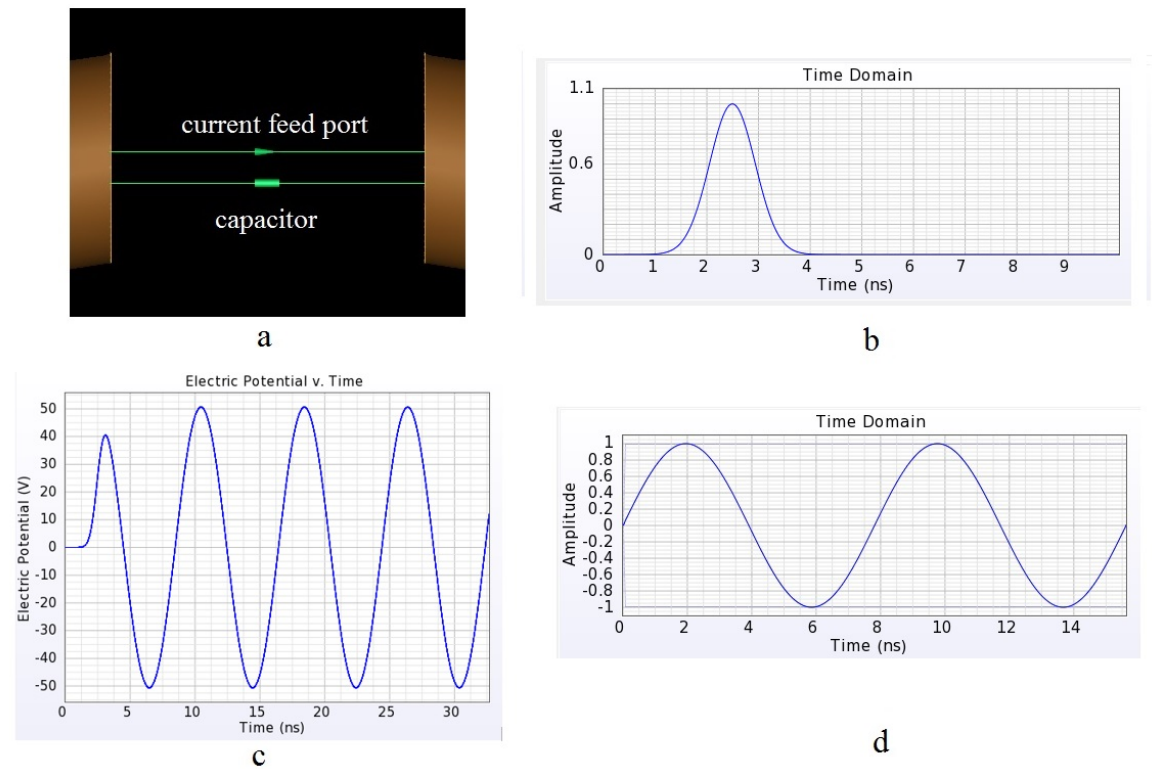
Figure 2. FDTD simulation setup: ( a ) current feed port and capacitor inserted in the coil; ( b ) Gaussian broadband pulse excitation used for Method A; ( c ) damping of the voltage oscillation on the capacitor with Method A; ( d ) sinusoidal excitation used for Method